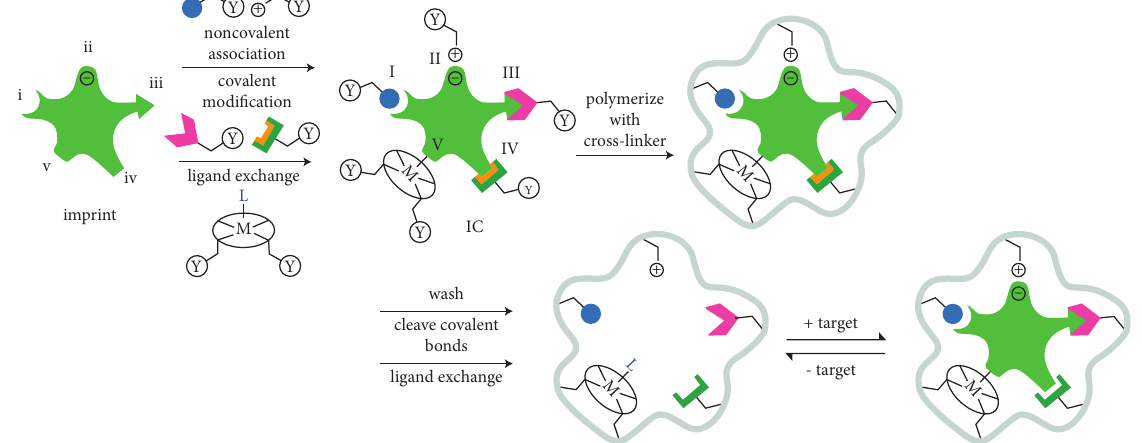
Figure 6: Overview of MIP imprinting [112].